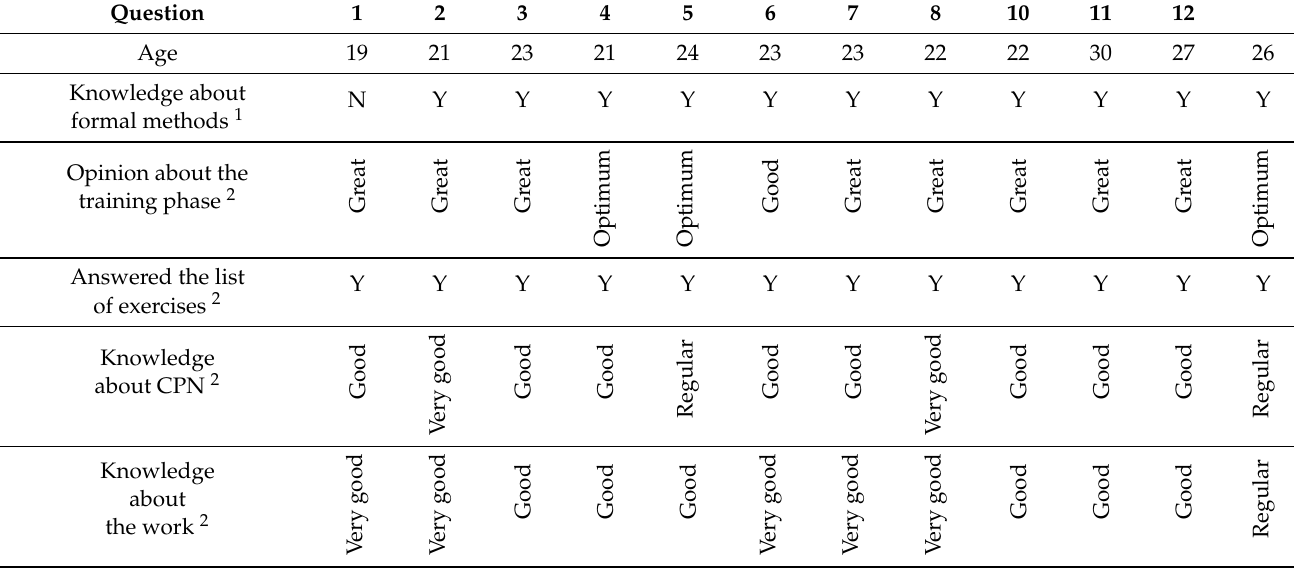
Table 2. Questionnaire identifying the modelers’